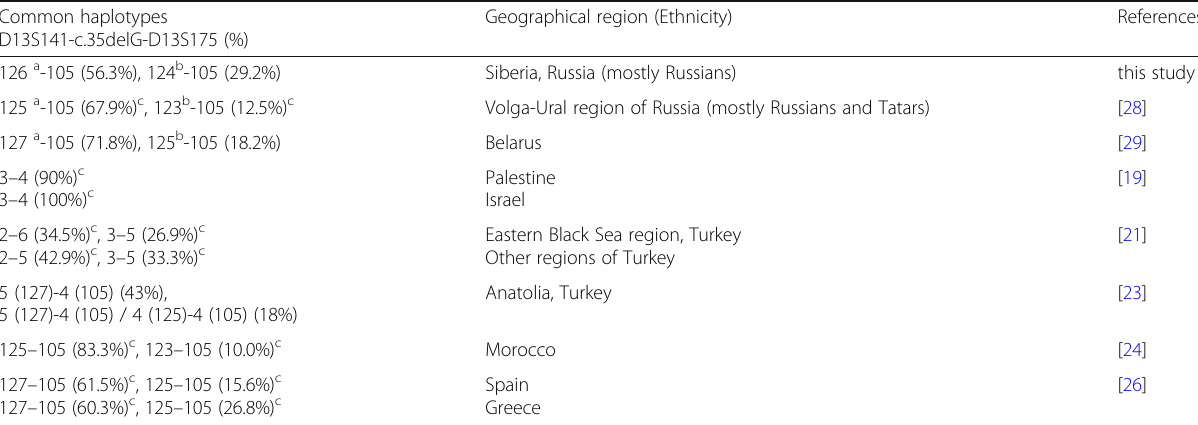
Table 3 The most common D13S141-c.35delG-D13S175 haplotypes in different